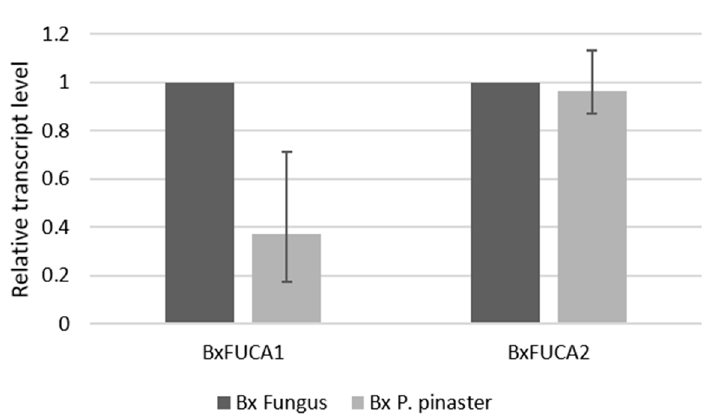
Figure 6. Relative transcript levels of BxFUCA1 and BxFUCA2 measured by RT-qPCR. Differences in BxFUCA1 and BXFUCA2 transcript levels between Bursaphelenchus xylophilus grown on fungus (Bx Fungus) and after Pinus pinaster pine extract stimulus (Bx P. pinaster). Bars represent the standard error range of three biological replicates.